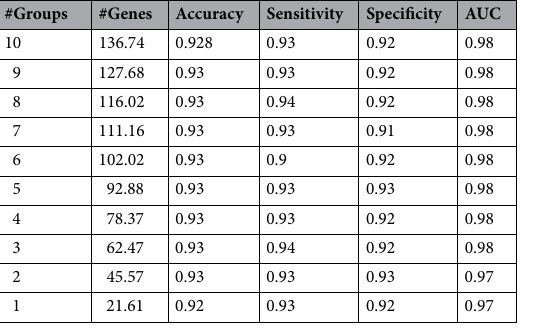
Table 4. An example averages of 100 MCCV performance table of GediNET for top-ranked 10 groups for GDS1962 dataset cumulatively.